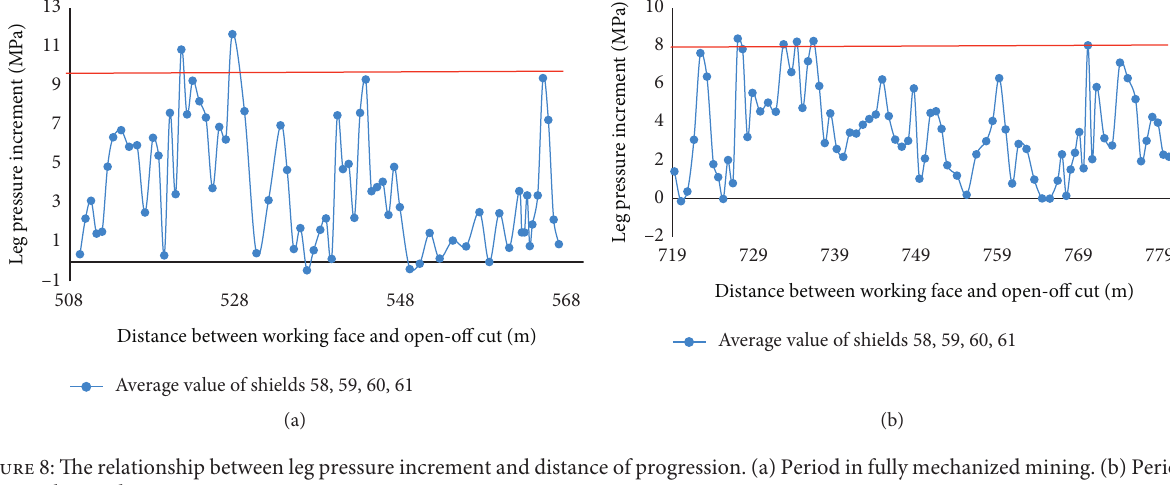
Figure 8: The relationship between leg pressure increment and distance of progression. (a) Period in fully mechanized mining. (b) Period in fully mechanized caving mining.